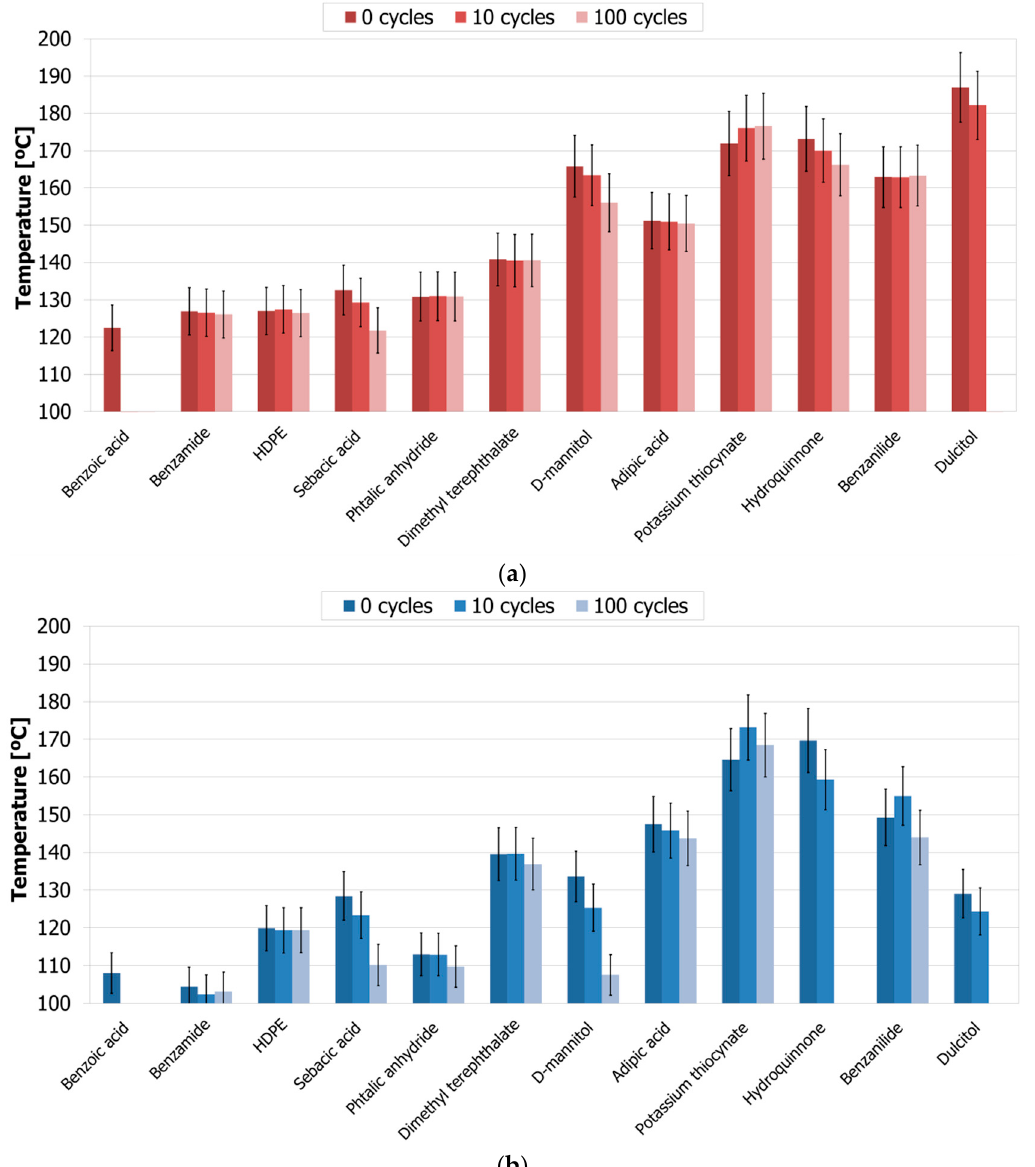
Figure 1. Phase change temperature: ( a ) melting; ( b ) solidification.